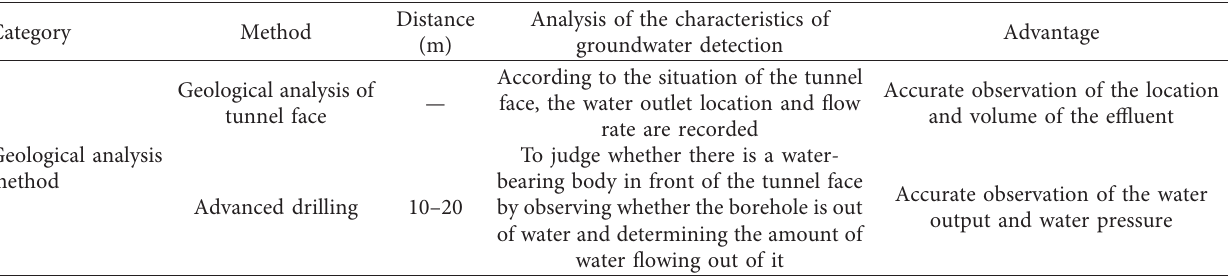
Table 13: Conventional advanced geological forecast methods and